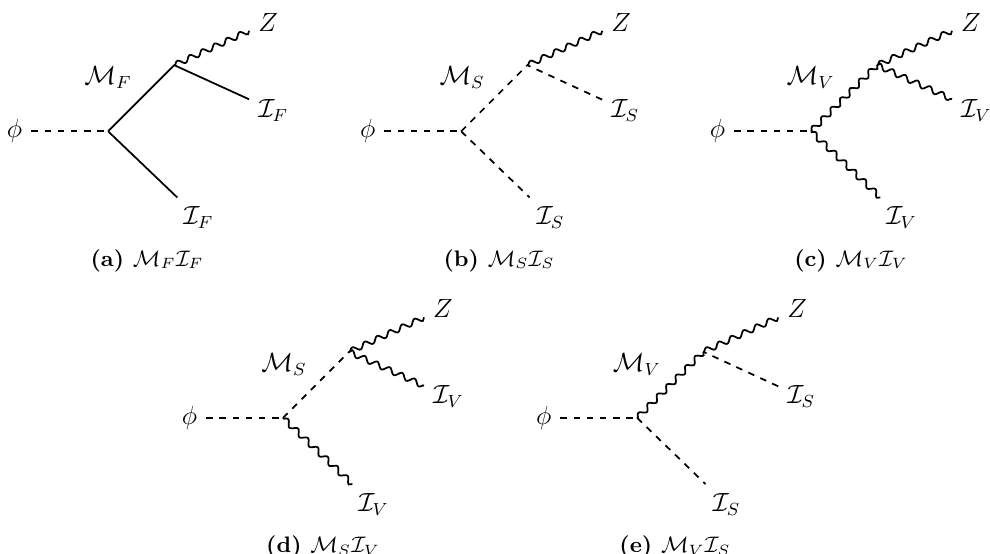
Figure 4. Mono- Z + E miss